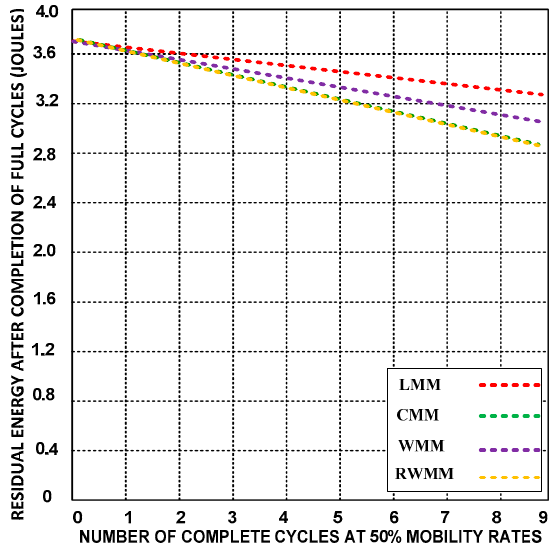
Figure 13. Residual energy after completion of nine cycles at 50% mobility rates.